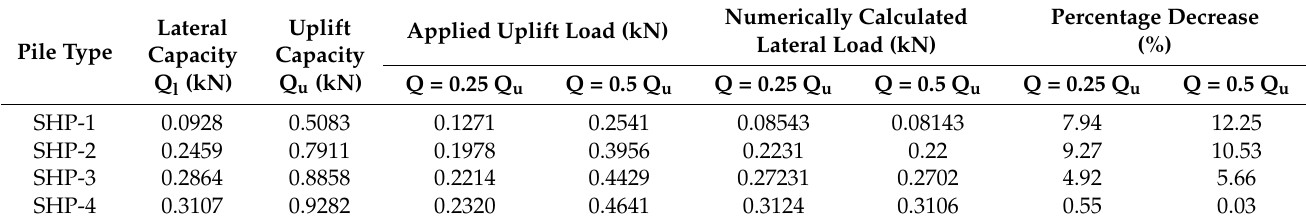
Table 4. Ultimate lateral capacity with and without uplift load.